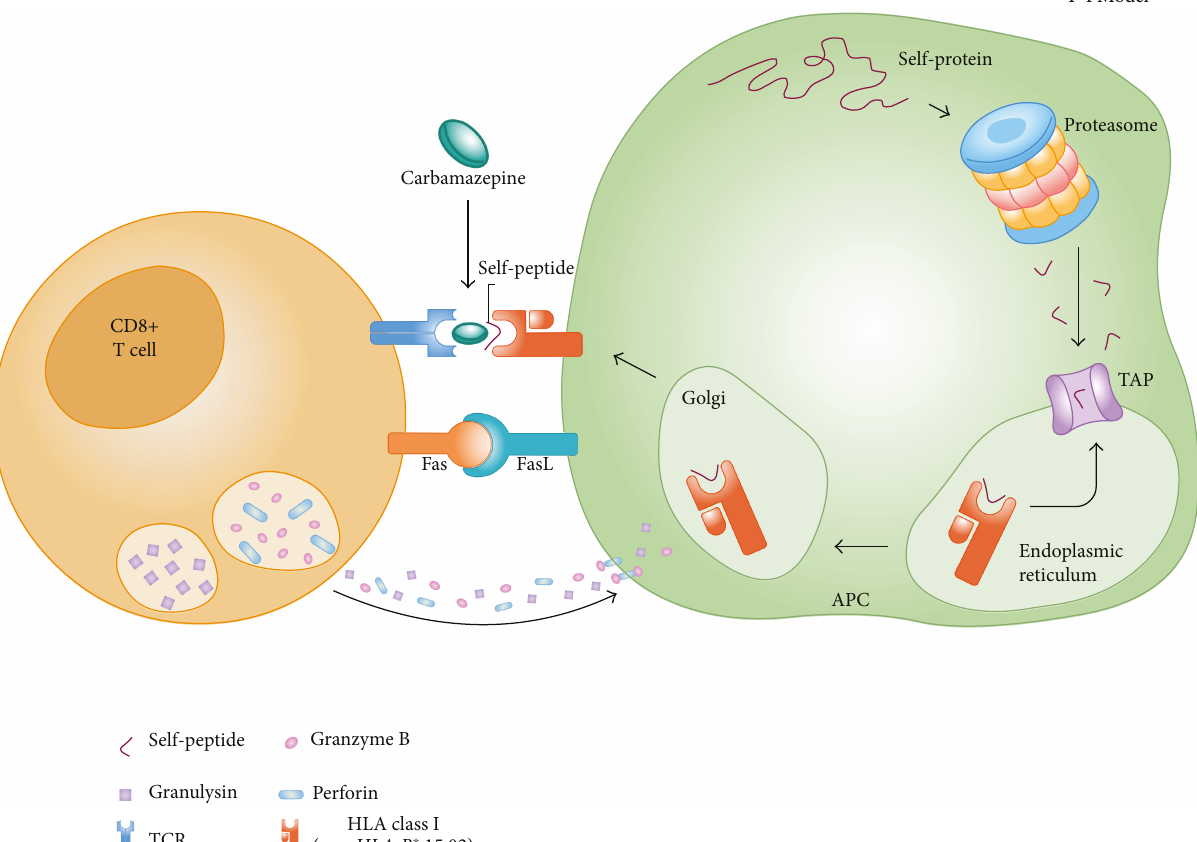
Figure 1: The “ pharmacological interaction with immune receptors (p – i) ” model of immune activation during carbamazepine-induced hypersensitivity